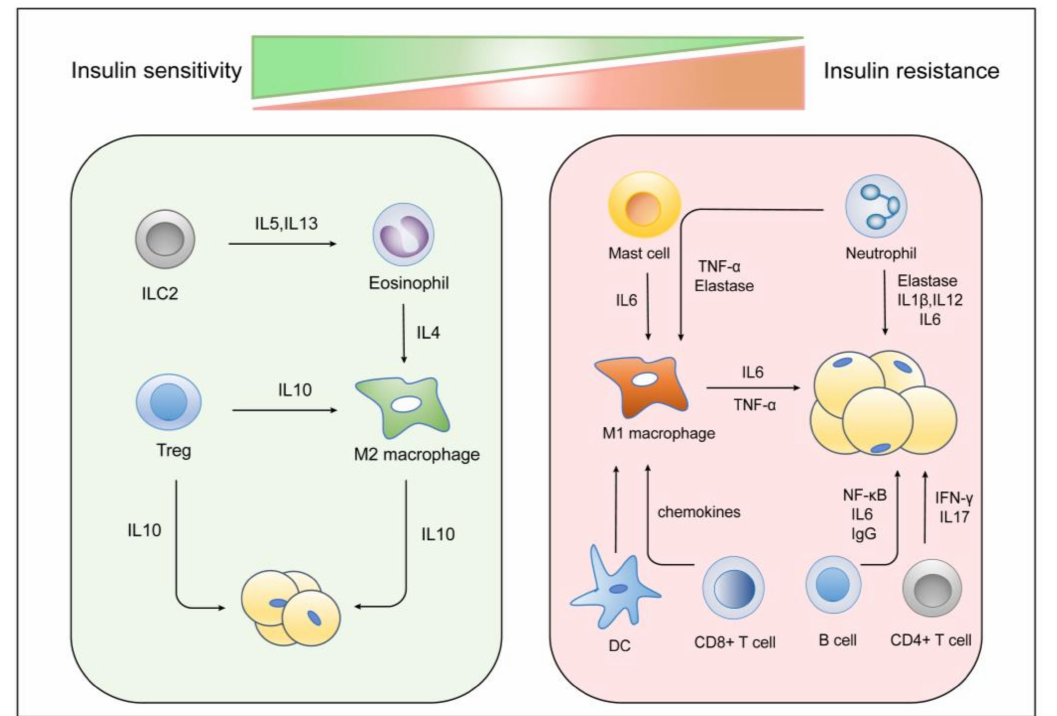
Figure 4. Role of the immune system in regulating polarization of macrophage and insulin resistance. In an insulin-sensitive state, ILC2 cells produce IL-5 and IL-13 to assist in the maturation and recruitment of eosinophils. Eosinophils and Treg cells promote the activation of M2 macrophages in the adipose tissue via IL-4 and IL-13 secretion. M2 macrophages and Treg cells secrete anti- inflammatory factors such as IL-10 to maintain insulin sensitivity in lean adipose tissue. In the obese state, recruitment of monocytes and differentiation into M1 macrophages are induced